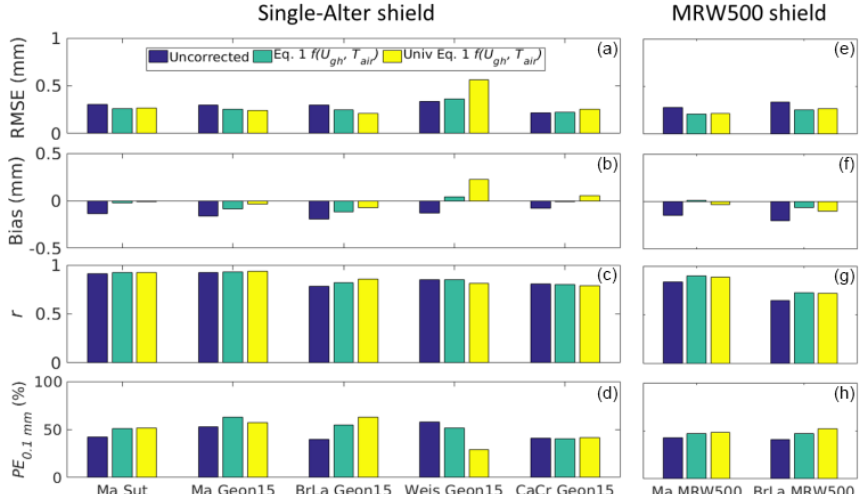
Figure 5. Error statistics calculated for the single-Alter shielded Marshall Sutron gauge (Ma Sut) and single-Alter shielded 1500mm Geonor gauges (Geon15) at the Marshall (Ma), Bratt’s Lake (BrLa), Weissfluhjoch (Weis), and Caribou Creek (CaCr) test beds (a–d) . Error statistics from the shielded MRW500 gauges from Marshall (Ma MRW500) and Bratt’s Lake (BrLa MRW500) are also shown (e–h) . The different statistics and correction types are described in the Fig. 4 caption. The results of the “universal” single-Alter transfer function (Univ. Eq. 1 – yellow), which were based on independent Eq. (1) coefficients derived in K2017a, are shown for all of the single-Alter shielded gauges and also for the gauges within the MRW500